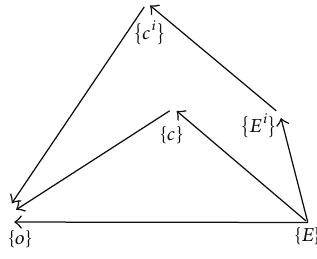
Figure 3: Scheme of hand-eye relationship